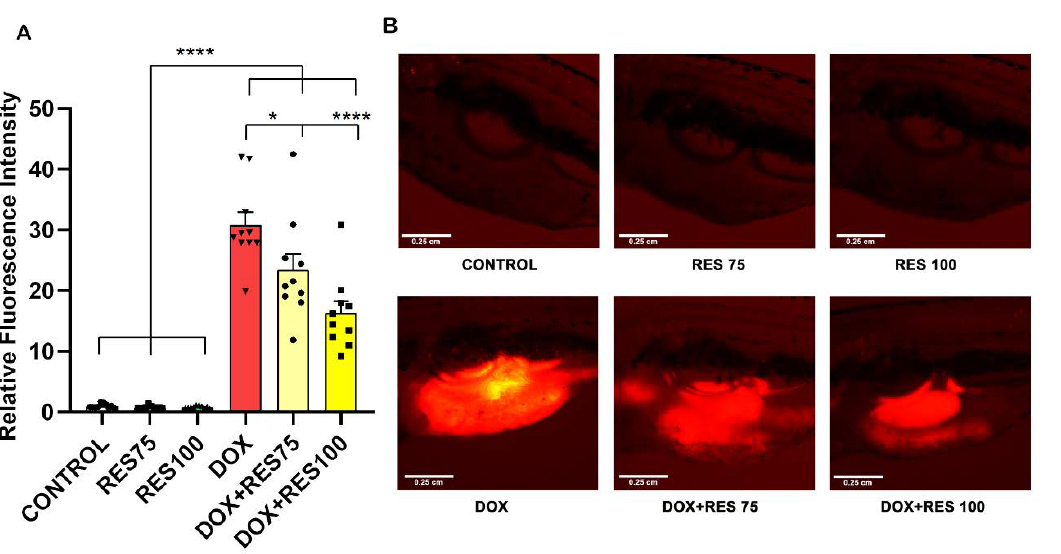
Figure 8. Reversal of Doxorubicin-induced mucositis by resveratrol. The ctsk reporter zebrafish transgenic line ( Tg[ctsk:DsRed ]) was exposed to different concentrations of resveratrol (RES, 75 µ M and 100 µ M) alone or together with doxorubicin (DOX, 17.2 µ M) for 96 h. The quantification of fluorescence intensity between the treatment groups performed using fluorescent images acquired with the same parameters and analyzed with ImageJ ( A ). ctsk signal in the abdominal area of fish from the different treatment groups ( B ). One-way ANOVA, Tukey’s multiple comparisons test, *— p ≤ 0.05, ****— p ≤ 0.0001.